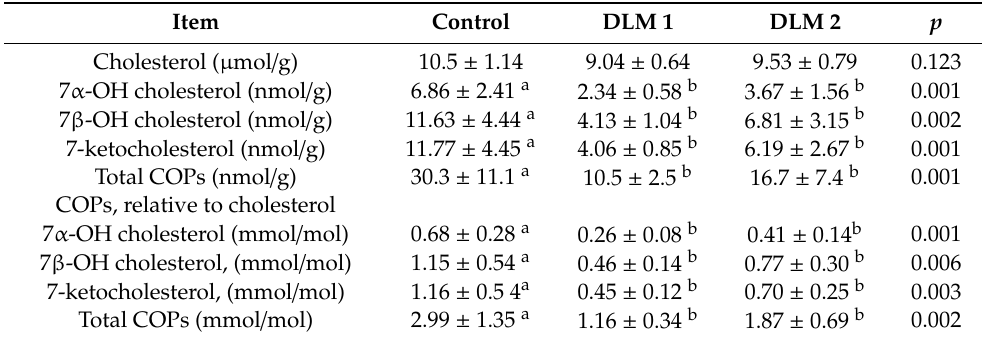
Table 5. Concentrations of cholesterol and cholesterol oxidation products (COPs) in heat-processed thigh muscle of broilers fed a control diet (control) or diets supplemented with two di ff erent levels of DL-methionine (DLM 1 and DLM 2) * , ‡ .